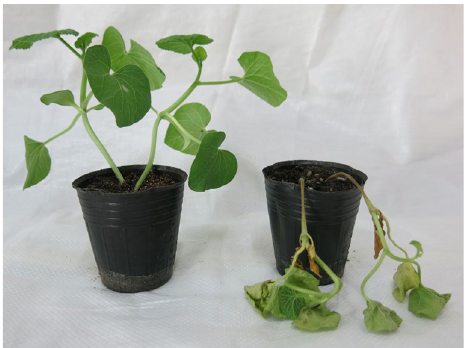
Figure 1. Phenotypes of ZQK9 (left) and E31 (right) 7 days post-inoculation.